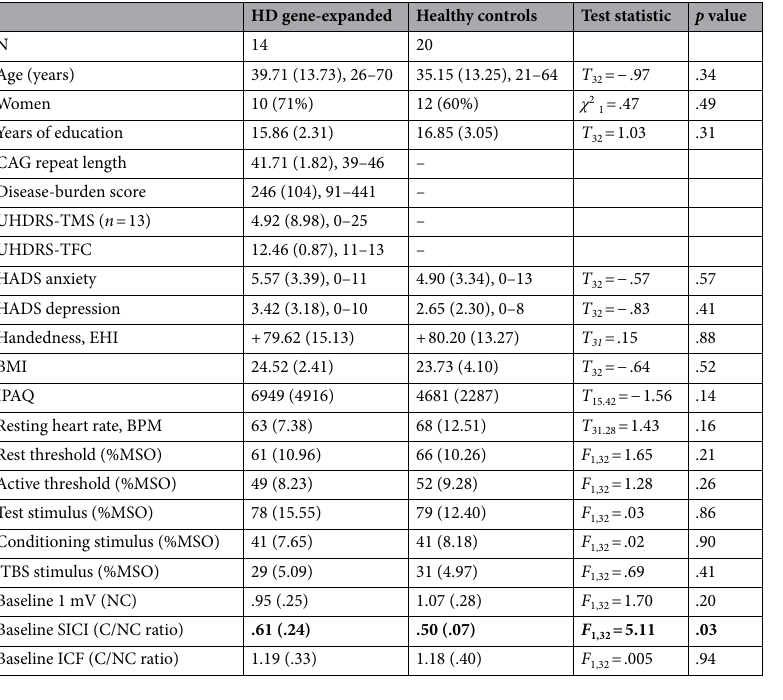
Table 1. Participant characteristics. Data are mean (SD), range or number (%). Significant values are in bold. UHDRS-TMS total motor score: possible scores range from 0 to 124, UHDRS-TFC total functional capacity: possible scores range from 0 to 13, UHDRS-TMS total motor score: possible scores range from 0 to 124, HADS hospital anxiety and depression scale, EHI Edinburgh handedness inventory, [range: − 100 (left-handed) to + 100 (right-handed)], BMI body mass index, IPAQ International physical activity questionnaire (higher scores indicate higher levels of physical activity), BPM beats per minute, RMT resting motor threshold, MSO maximum stimulator output, AMT active motor threshold with monophasic stimulation, TS test stimulus, CS conditioning stimulus, iTBS intermittent theta burst stimulation, NC non-conditioned, C conditioned, SICI short interval intracortical inhibition, ICF intracortical